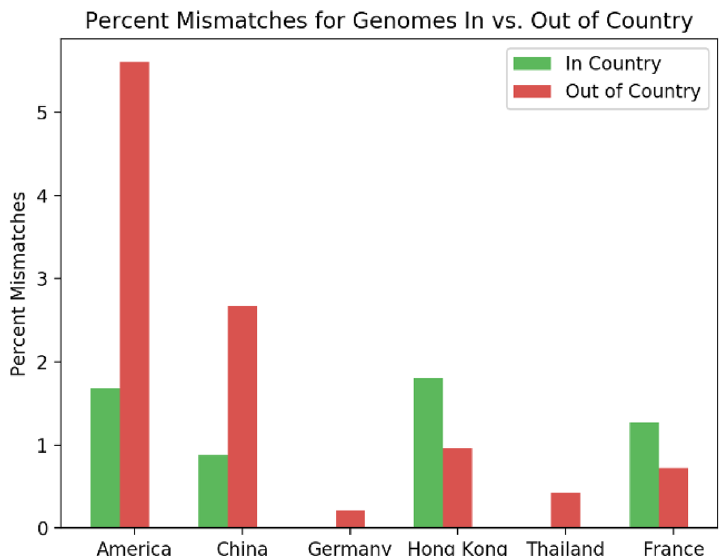
Figure 5. Number of mismatches for each PCR test tested on all SARS-CoV-2 genomes, split between genomes collected within the same country as the test and outside the country. For Japan, 100% of genomes, both in and out of the country, have 1 mismatch, and therefore not shown in the figure. For 9 out of the 11 PCR tests, there are a higher number of mismatches for total genomes that occur outside the country than genomes that occur inside the